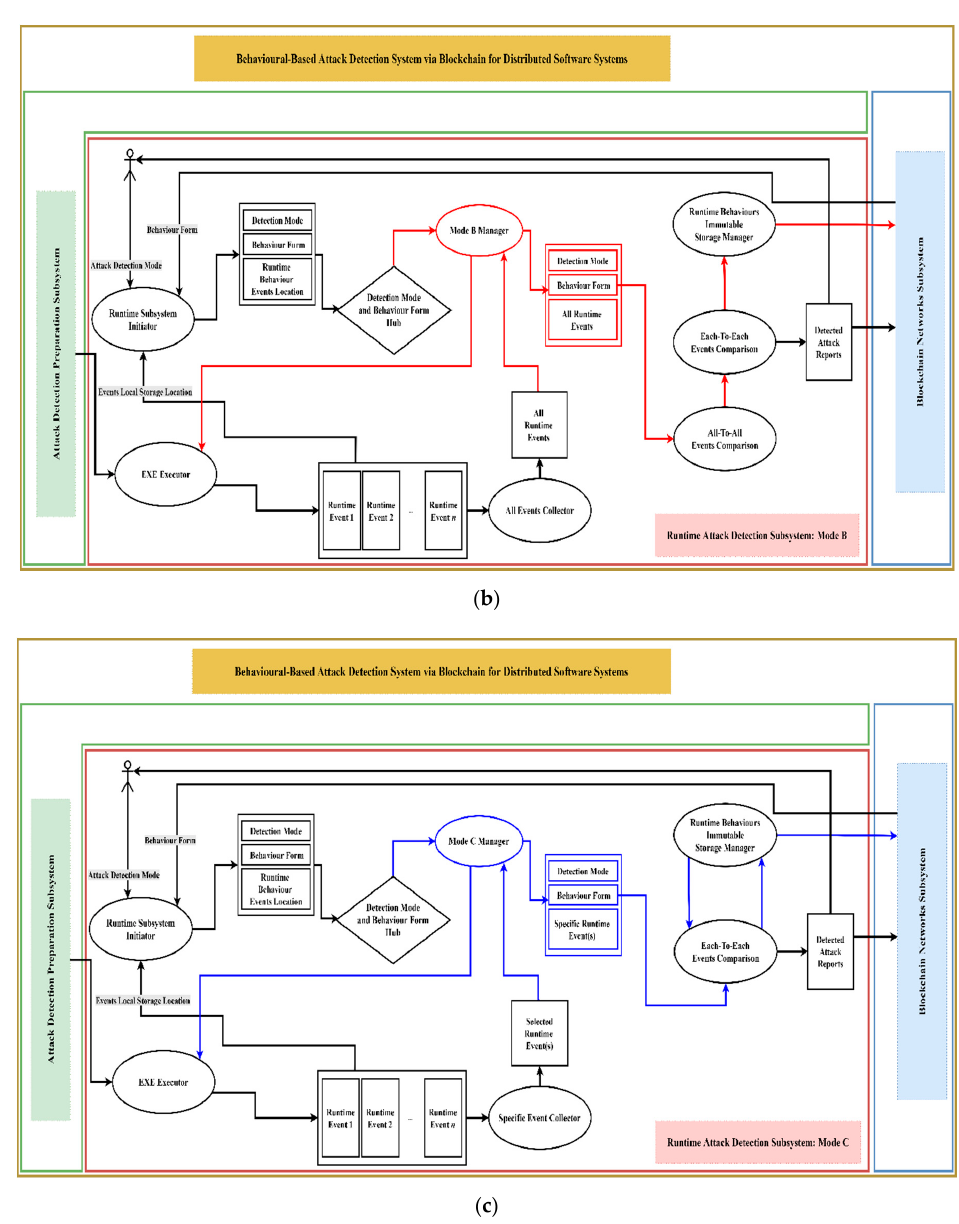
Figure 5. Runtime Attack Detection (RAD) Subsystem software system architectures for ( a ) Mode A; ( b ) Mode B; ( c ) Mode C.